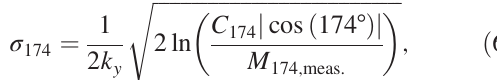
FIG. 7. Comparison of measured vertical emittance at three locations using different methods versus beam intensity. Emit- tance at the IP was measured only for one beam intensity but this study is